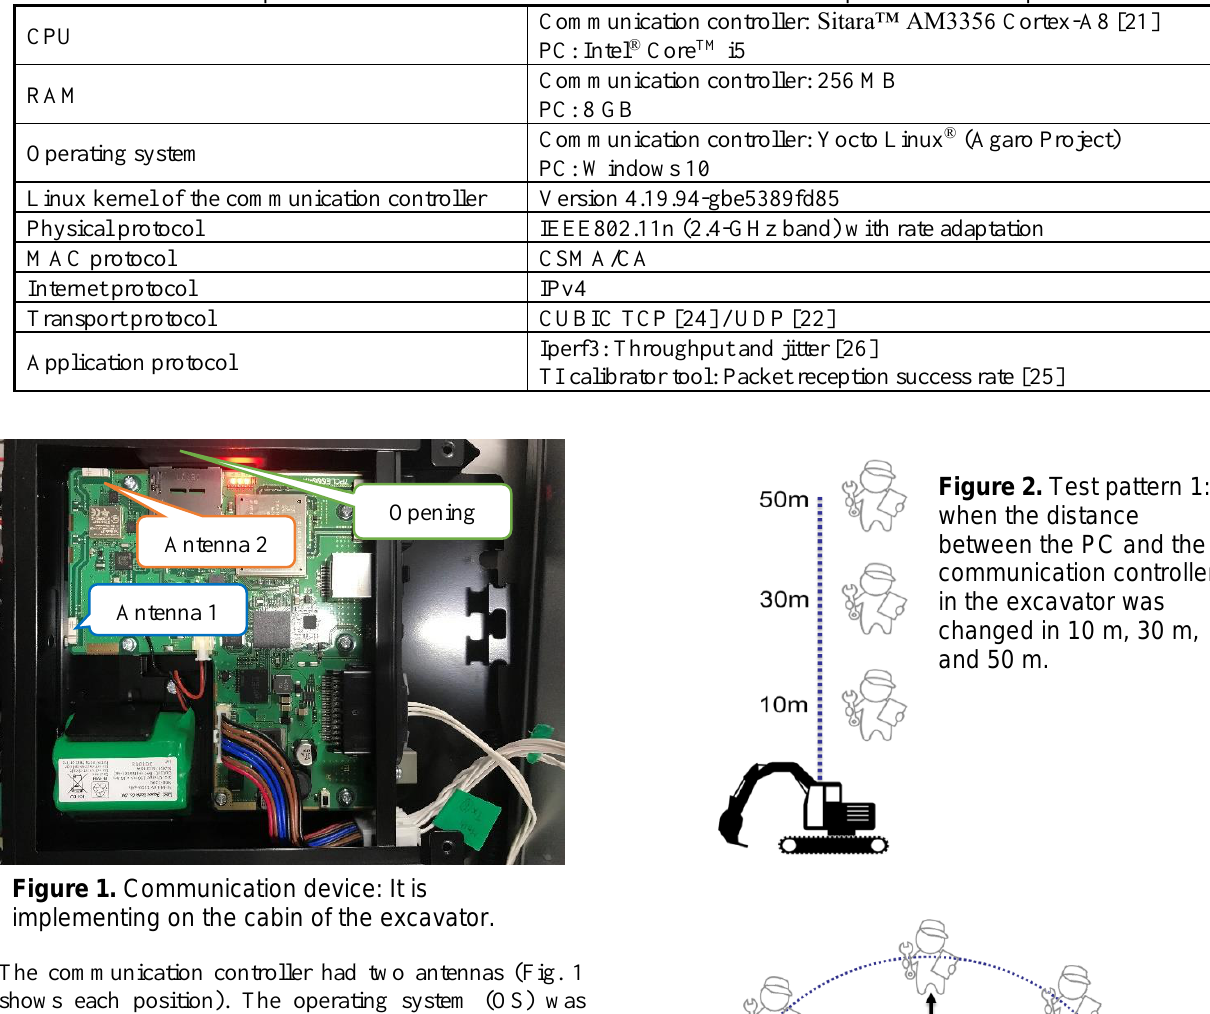
Table 1. Experimental environment for communication: Device specification and protocol.